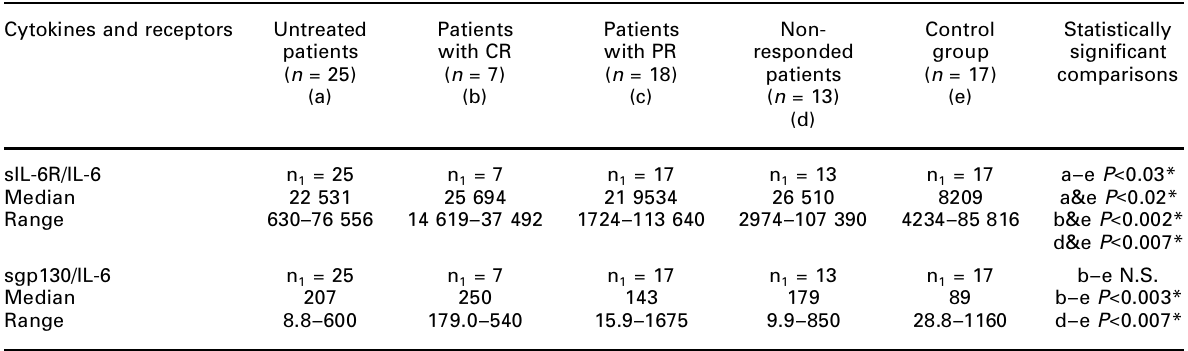
Table 5. sIL-6R/IL-6 ratio and sgp130/IL-6 ratio in the patients with CLL according to treatment response. Median and range in parentheses. Cytokines and